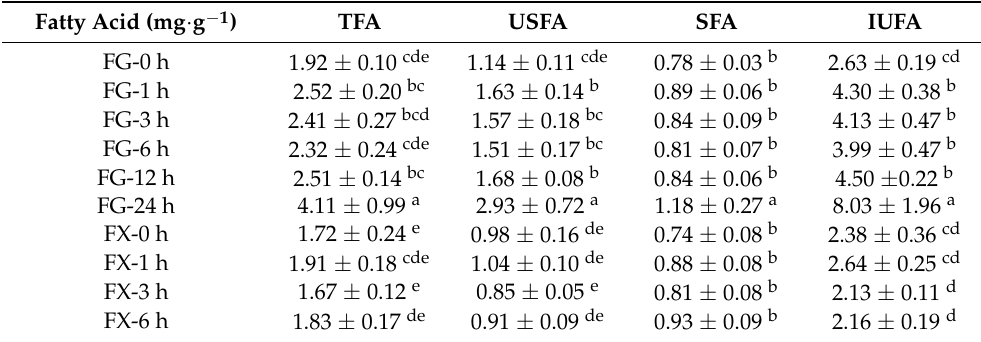
Table 1. Indexes of fatty acid composition in FG and FX leaf samples under 4 ◦ C low-temperature stress for 24